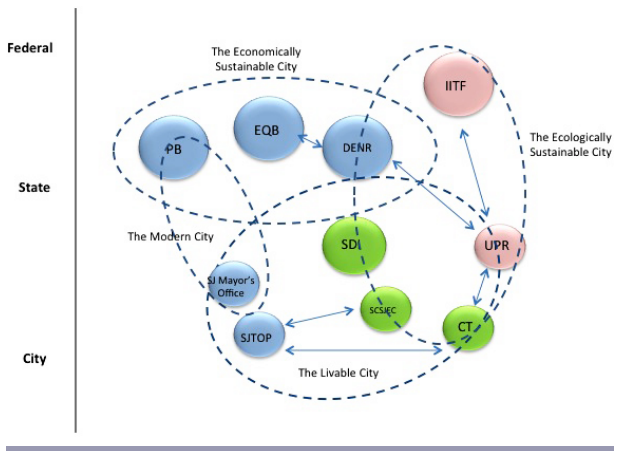
Fig. 2 . Map of future urban visions of San Juan and central actors in the knowledge network. Detailed picture of the central actors in the knowledge network of San Juan and their future visions of the city. IITF: International Institute of Tropical Forestry; PB: Puerto Rico Planning Board; EQB: Puerto Rico Environmental Quality Board; DENR: Puerto Rico Department of the Environment and Natural Resources; UPR: University of Puerto Rico; CT: Conservation Trust; SJM: San Juan Municipality; SDI: Sustainable Development Institute; SCSJEC: Special Commission for the San Juan Ecological Corridor. Blue color indicates local or state agency, green color indicates local NGO, and purple color indicates research/academic institution. Circles with dash lines represent the different future visions that these actors